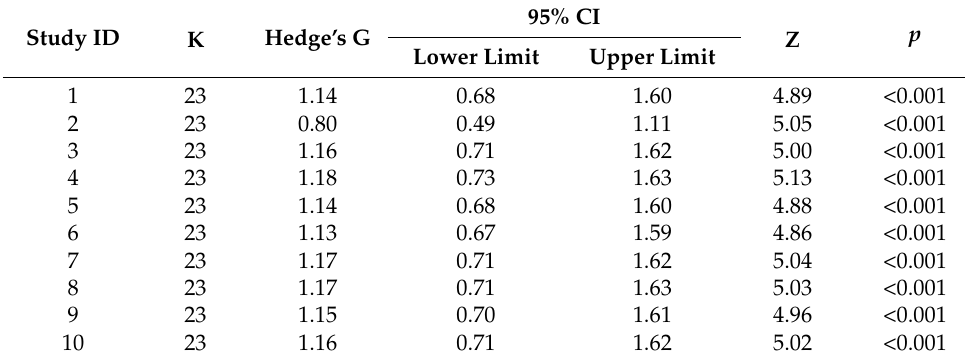
Table 6. Exclusion sensitivity test of the nurse support